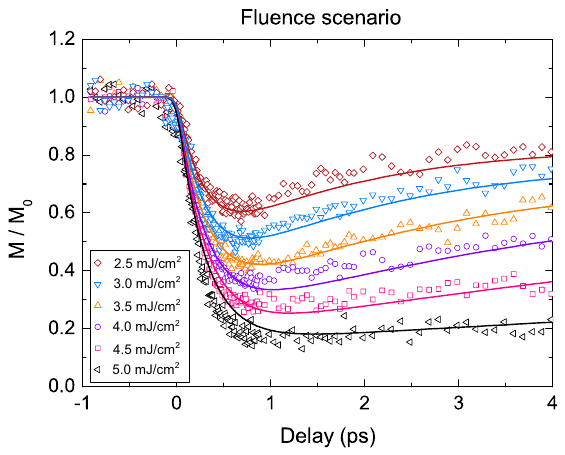
FIG. 2. Fluence dependence of the laser-induced magnetiza- tion dynamics of nickel at room temperature ( T ambient ¼ 300 K ). The fluence is adjusted to six levels of the pump pulse ranging from 2 : 5 – 5 : 0 mJ = cm 2 in steps of 0 : 5 mJ = cm 2 . (Symbols corre- spond to measurements.) The magnetization is normalized to its value at negative time delays. Lines are calculations with the refined M3TM, using the microscopic parameters obtained by fitting the 3 : 5 mJ = cm 2 measurement.